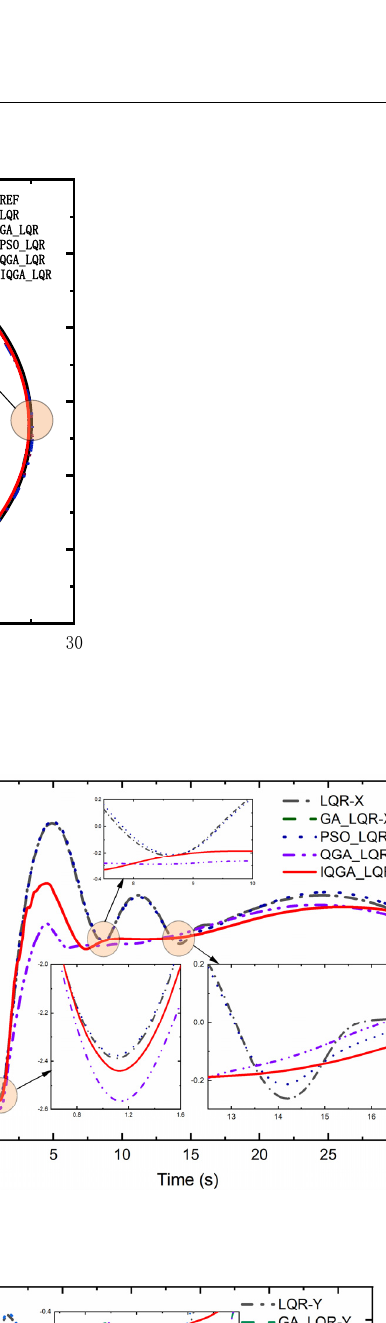
Figure 5. Lateral displacement and deviation.